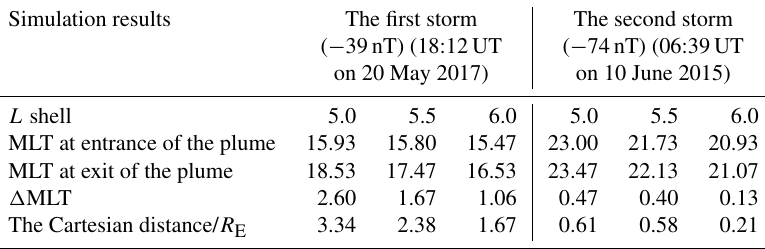
Table 2. The widths of the simulated plume at different L shells during the above two geomagnetic storms. Simulation results The first